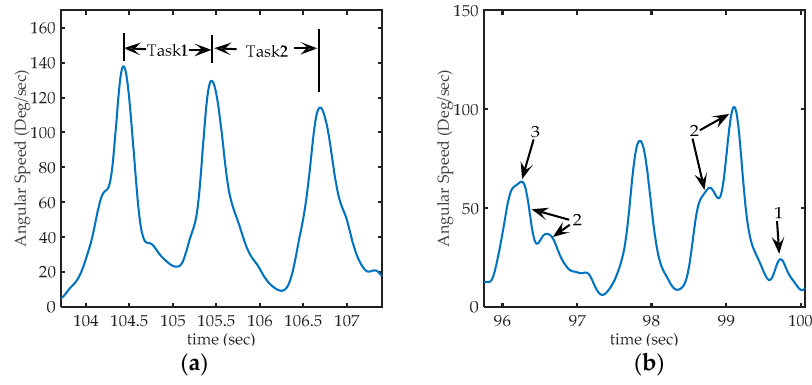
Figure 6. Sections of S ω acquired from sensor 1 (in the back of the hand), ( a ) Representation of peaks on S ω signal on third exercise: The first peak corresponds to the time where a PB is collected from deposit, the second peak, corresponding to the instant at which the PB is placed in the corresponding peg and, the third peak corresponds to the action of taking the next PB. Task1 occurred between the first and second peak, and Task2 occurred between the second and third peak; ( b ) Some particular cases of peaks that can be found in the S ω signal. Arrow 1: shows a peak too small to be considered a voluntary movement (to be discarded), Arrows 2: shows sets of nearby peaks that represent single movements, and arrow 3, shows a much smaller peak, but not small enough to be eliminated (it represents a hand movement).